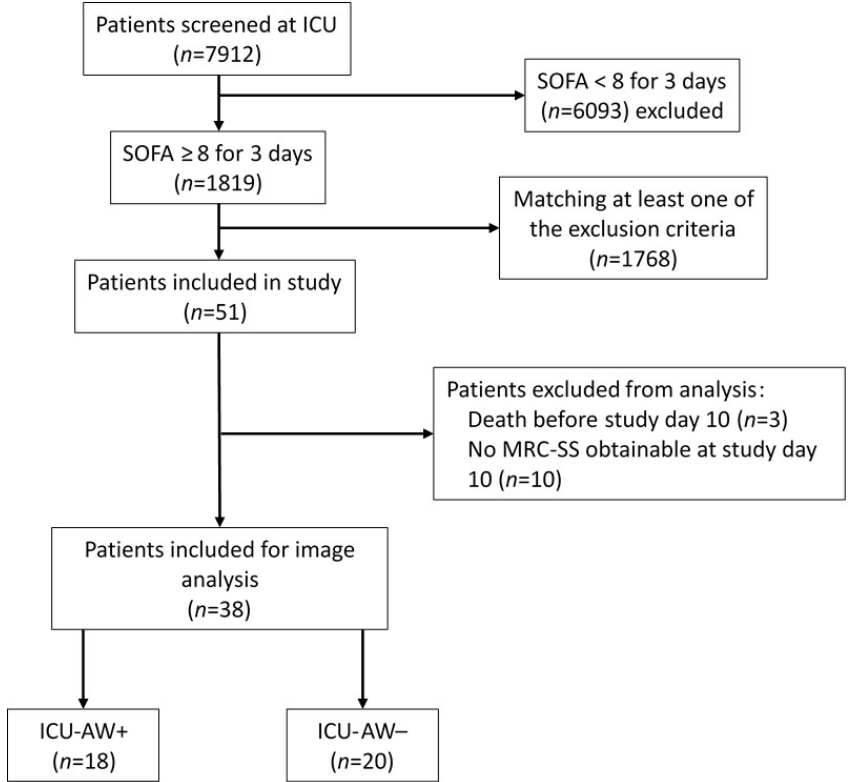
Figure 1. Flowchart of patient screening and study cohort inclusion. Feasibility of MRC-SS testing was checked by using standardized requests the patient had to follow: “Open and close your eyes”, “Look at me”, “Open your mouth and put out your tongue“, “Nod your head”, “Raise your eyebrows until I have counted to five”. ICU-AW was assumed with an MRC-SS < 48. ICU-AW+: patients with intensive care unit-acquired weakness. ICU-AW−: patients without intensive care unit-acquired weakness. ICU: intensive care unit. MRC-SS: Medical Research Council sum score. SOFA: Sequential Organ Failure Assessment score. Table 1. Study population characteristics. Statistically significant p values ( p < 0.05) are printed in bold. The results are rounded to the first decimal place. APACHE II: Acute Physiology and Chronic Health Evaluation Score II. BMI: body mass index. ICU-AW: intensive care unit-acquired weakness. ICU: intensive care unit. MRC-SS: Medical Research Council sum score. mRS: modified Rankin scale. N/A: value not available. SD: standard deviation. SOFA: Sequential Organ Failure Assessment